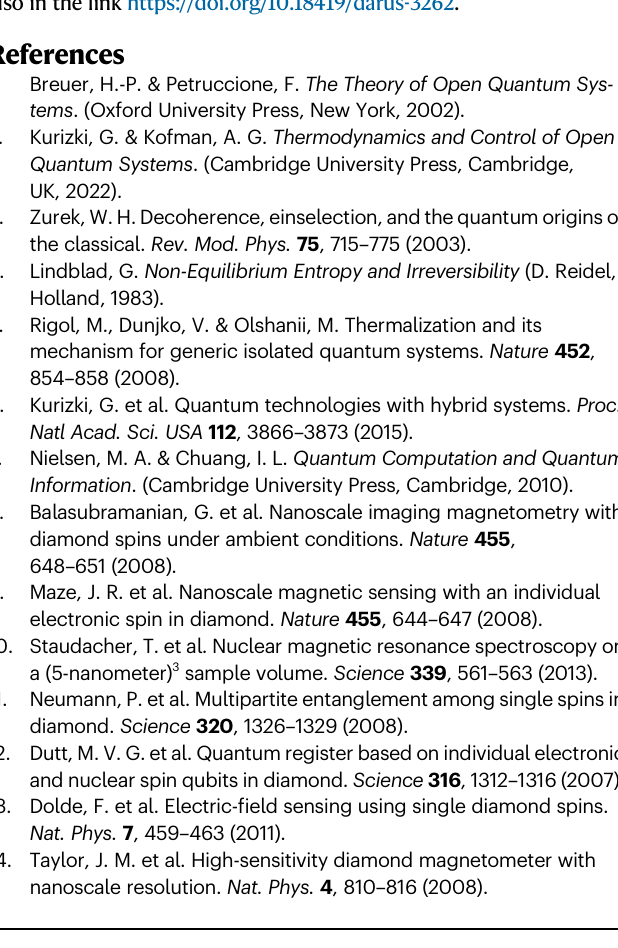
Figure 3a:All solid-line fi ts toall the curvestake asimpleanalytical form C ð t Þ =1 = 2+ a e (cid:4)ð t = T Þ 2 Þ cos ω t , with a , T and ω B being the fi tting B parameters.Forthe M 4,0 sequence a = 0.18, T =1.2 nsand ω B =530kHz. Similarly for M 0,4 sequence a =0.18, T =1.2 μ s and ω B =0. For the average FID curve a =0.18, T =0.6 μ s, and ω B =0. Figure3b:With asimilar analytical fi tfunction givenabovewe fi nd (i) for the M 4,0 sequence a = 0.16, T =2.37 μ s and ω B =313.5kHz, (ii) for M 0,4 sequence a = 0.18, T =2 ns and ω B = 0 and (iii) for the average FID curve a =0.12, T =0.6 ns and ω B = 0. Figure 4: The solid-line fi t (orange line) takes the exponential decayform1 = 2+ a exp ð(cid:4) bt Þ with a , b as fi ttingparameters.Thebest fi t for the experimental data are a =0.1448 and 1/ b =0.2826